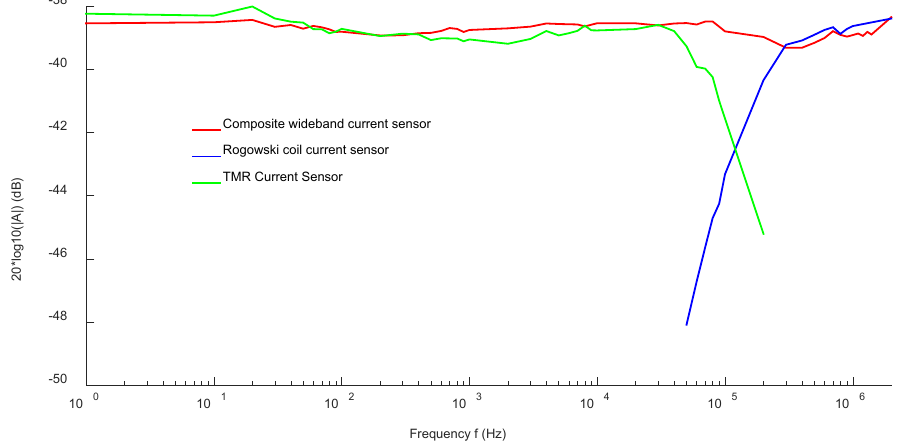
Figure 23. Magnitude-frequency response curve of a non-contact composite broadband current sensor.